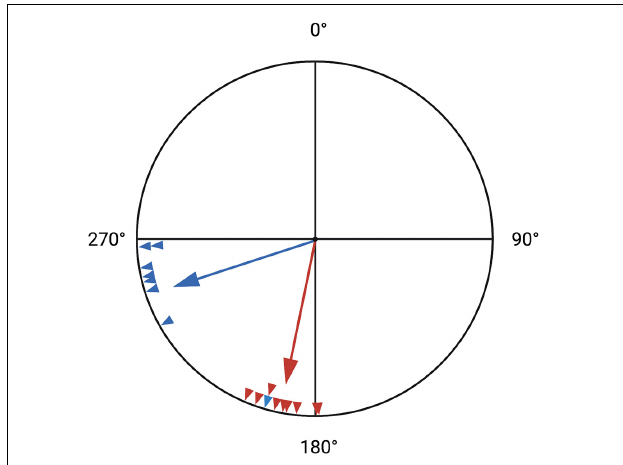
FIGURE 3 | Last observed direction of white-crowned sparrows after experimental displacement east of their location. Adults (blue, large arrow is the average) correctly reoriented southwest toward their original wintering grounds, exhibiting true navigation. Juveniles (red, large arrow is the average) failed to reorient, continuing southward using vector navigation. Based on Thorup et al.